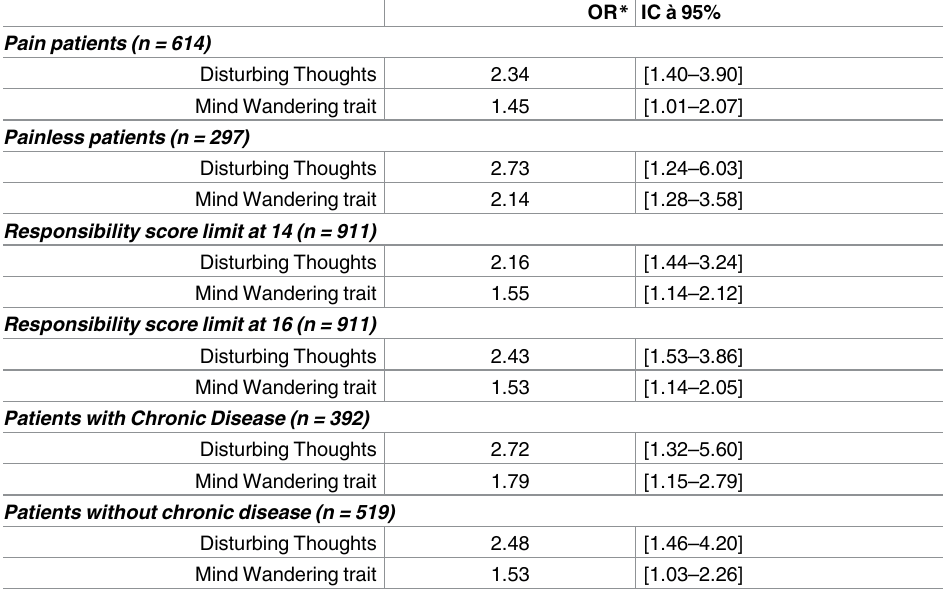
Table 3. Sensitivity analysesof responsibility risk factors in road